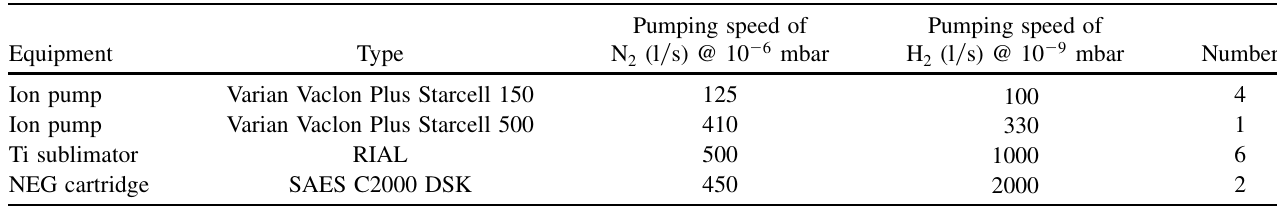
TABLE IV. Pumping capacity of the WSV50.